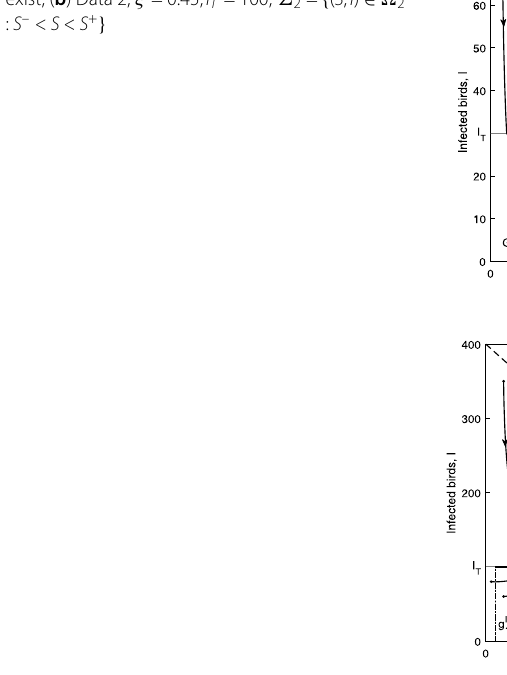
Figure 3 E R 2 is globally asymptotically stable in Case A.1: ( a ) Data 1, ξ = 0.07, I T = 30, (cid:5) 2 does not